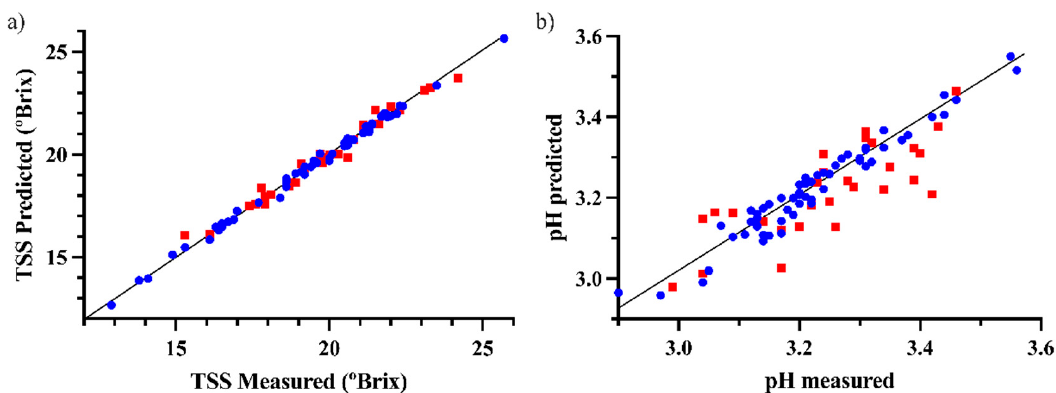
Figure 2. Predicted vs. measured values for the best prediction models of ( a ) TSS and ( b ) pH (blue circles for calibration samples, red squares for validation samples).